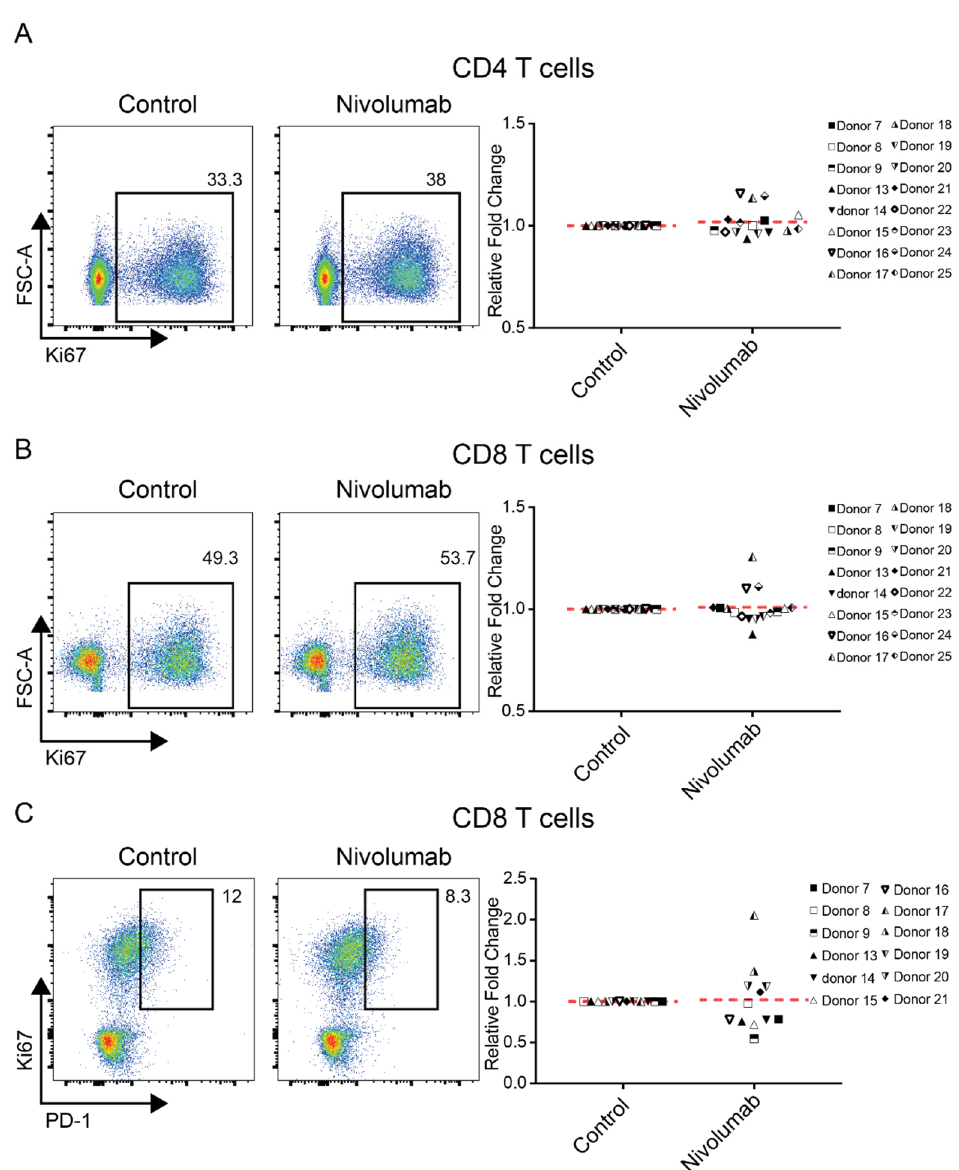
Figure 3. Nivolumab treatment does not impact T cell proliferation. Frozen PBMCs were thawed and cultured in RPMI1640 medium containing 5% AB human serum. Cells were then treated with Nivolumab (20 μ g/mL) in the presence of anti-CD3 mAb (0.1 μ g/mL) for three days and harvested for flow cytometric analysis of expression of the T cell proliferation marker Ki67 ( n = 16). Shown is the expression of Ki67 in CD4 + T cells ( A ) and CD8 + T cells ( B ). ( C ) The expression of PD-1 + Ki67 + on CD8 + T cells is shown. The left panels show the data from one representative donor, whereas the right panel provides a summary of data from 12 different individual donors.